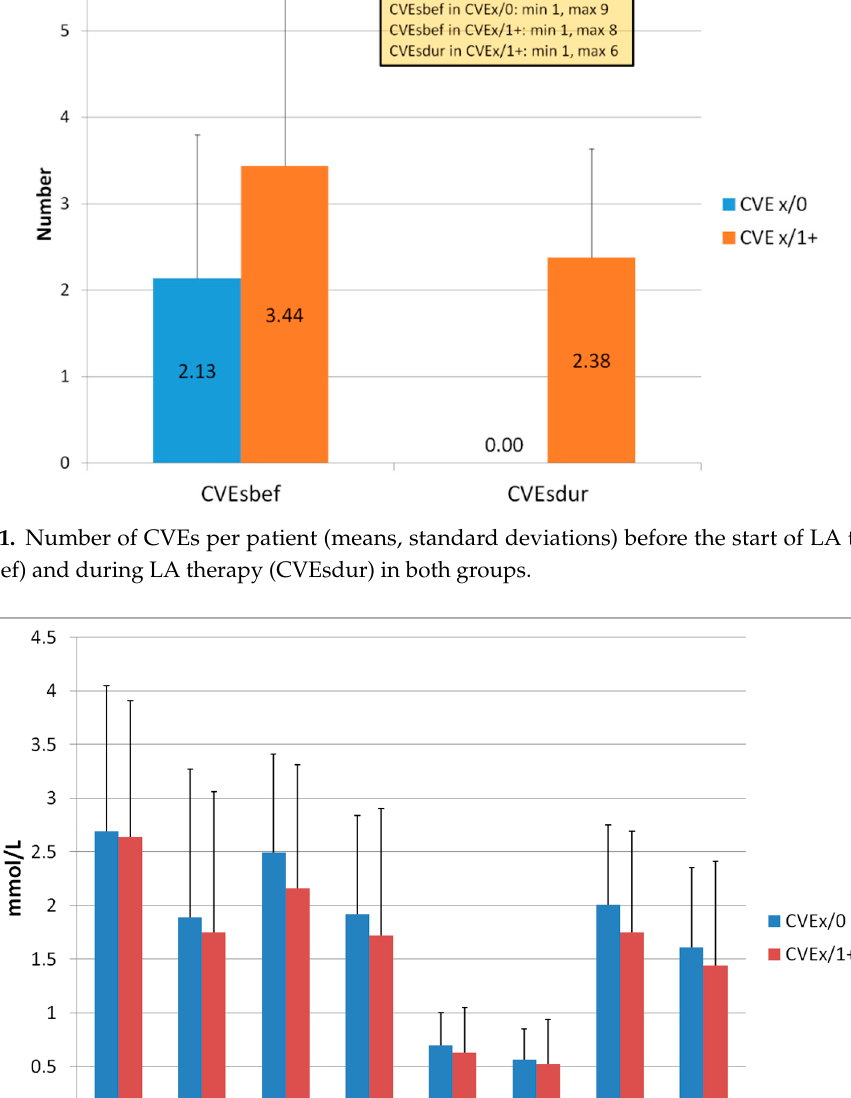
Figure 1. Number of CVEs per patient (means, standard deviations) before the start of LA therapy (CVEsbef) and during LA therapy (CVEsdur) in both groups.